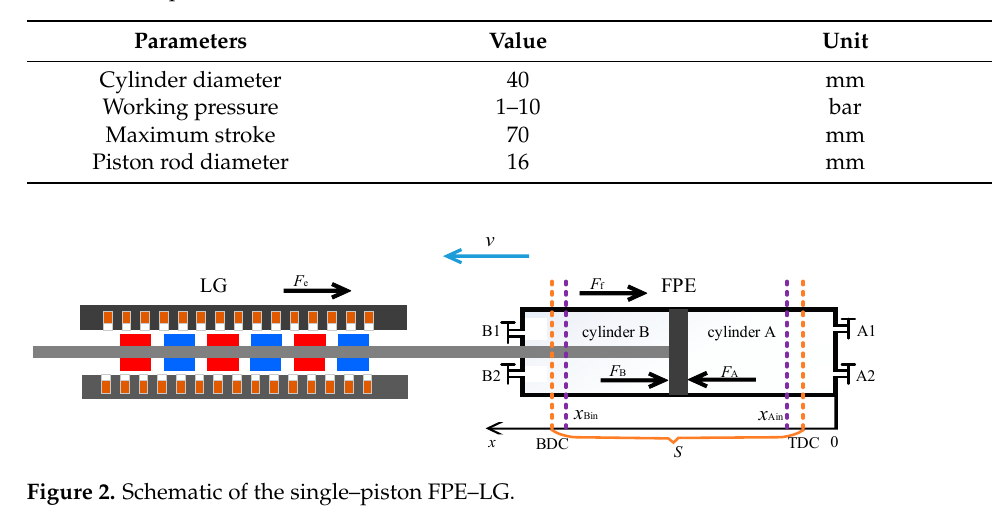
Figure 1. Single–piston FPE–LG test rig. Table 1. Main parameters of FPE–LG.